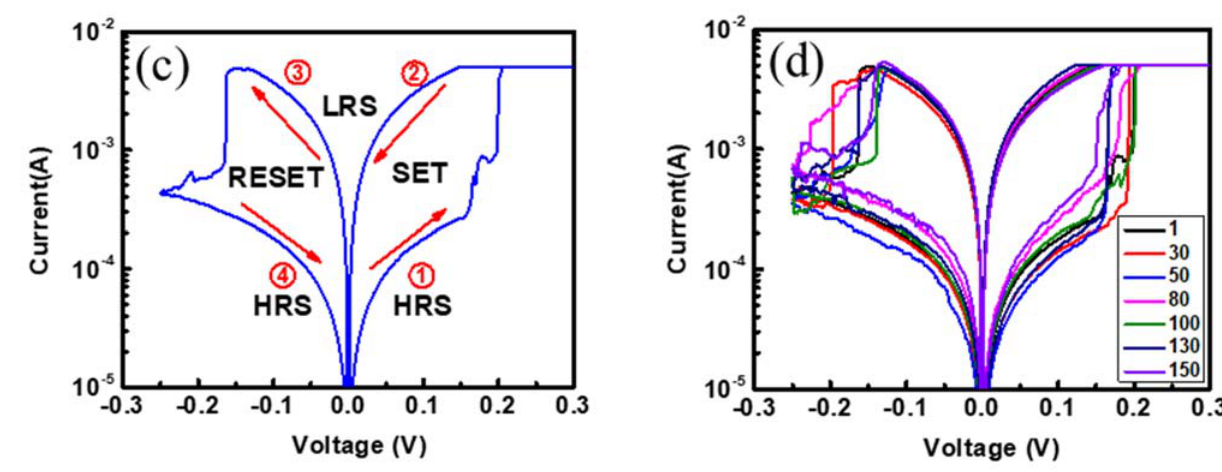
Figure 3. ( a ) The I-V curve under a compliance current limit, showing Ohmic behavior with WTe 2 film. ( b ) I-V characteristics of Ag/SnO 2 /Au memristive structure with high RESET and SET voltages. ( c ) I-V characteristics of Ag/SnO 2 /WTe 2 /Au memristive structure with RESET and SET states. ( d ) The consecutive 150 cycles of bilayer memory devices over the flexible PET substrate show high stability.